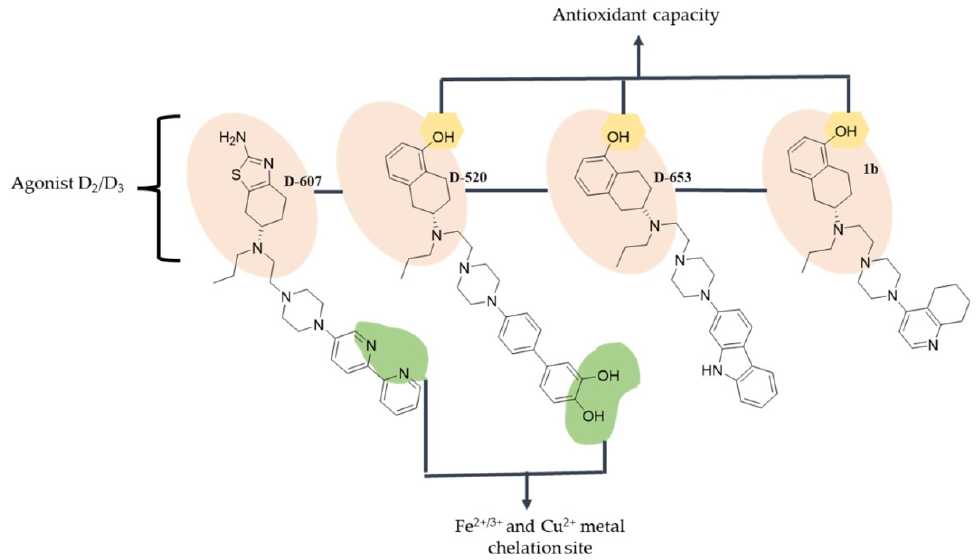
Figure 6. Structure of piperazine with neuroprotective activity. Green shadowing shows iron chelation sites; yellow shadowing shows free radical scavenger sites.